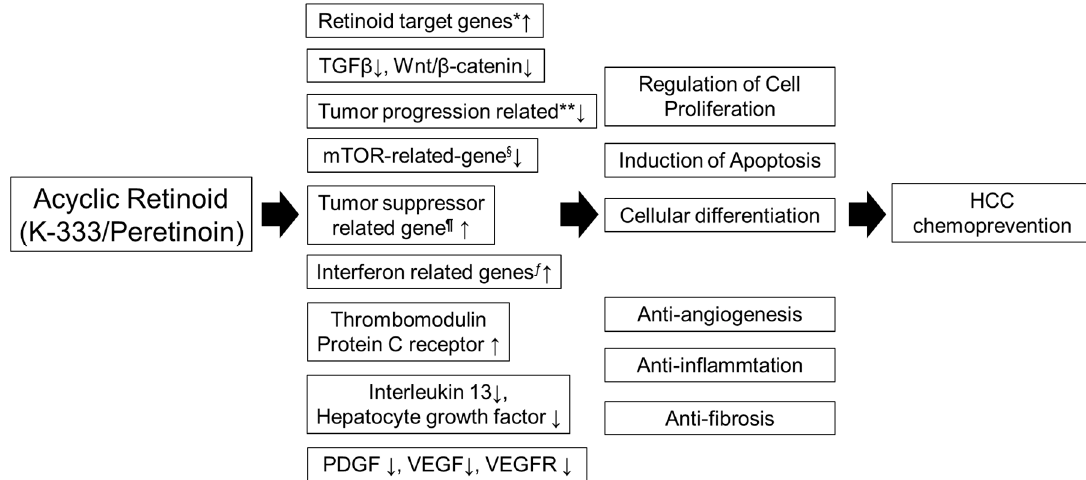
Figure 1. Molecular pathway of peretinoin. Peretinoin enhances the expression of multiple retinoid target genes. Through the retinoid target gene, peretinoin inhibits HCC proliferation, suppresses tumor growth and induces tumor apoptosis. In addition to enhancing retinoid target gene expression, peretinoin induces changes in the expression levels of a variety of genes involved in hepatocarcinogenesis, such as those related to Wnt signaling, IGF signaling, interferon, mTOR, and cell cycle regulation. Therefore, peretinoin modulates multiple signaling cascades involved in carcinogenesis, either directly or indirectly. HCC, hepatocellular carcinoma; IGF, insulin-like growth factor; mTOR, mammalian target of rapamycin; VEGF, vascular endothelial growth factor; PDGF, platelet-derived growth factor.* cytochrome P450, family 26, subfamily B, polypeptide 1, insulin-like growth factor binding protein 6, regulatory factor X-associated ankyrin-containing protein, putative lymphocyte G0/G1 switch gene, retinol binding protein 1, retinol binding protein 4, retinoic acid induced 3, transglutaminase 2, CCAAT/enhancer binding protein (C/EBP). ** junctional adhesion molecule 3, V-myc myelocytomatosis viral oncogene homolog, Src-like-adaptor, cell division cycle 2, G1 to S and G2 to M, BCL2-associated athanogene, chemokine (C-C motif) receptor 9, pre-B-cell leukemia transcription factor 1. § FK506 binding protein 12-rapamycin associated protein 1. ¶ Jumonji domain containing 3, jumping translocation breakpoint, protein kinase, AMP-activated, alpha 2 catalytic subunit. ƒ guanylate binding protein 1, interferon-inducible, 67kDa, interferon-induced protein 44, chemokine (C-X-C motif) ligand 9.